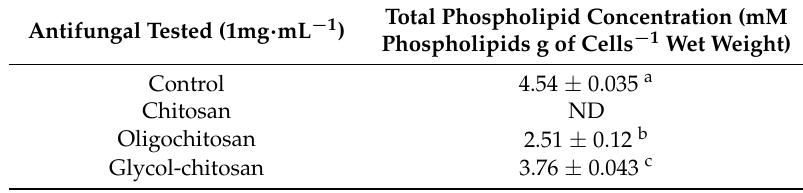
Table 1. Total phospholipid concentration (mM phospholipids g of cells − 1 ) in the membrane fraction of U. maydis growth under antifungal treatments.